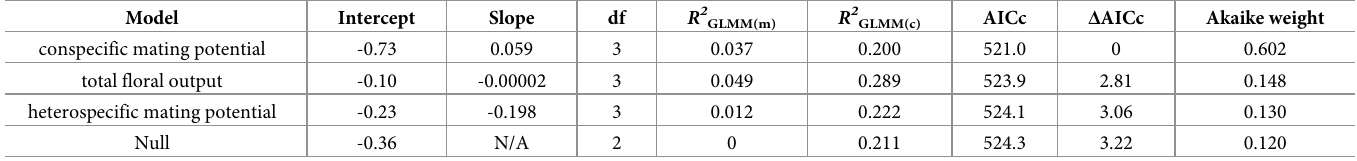
Table 4. Summary of model selection results for fertilization rate in C . orbiculatus .